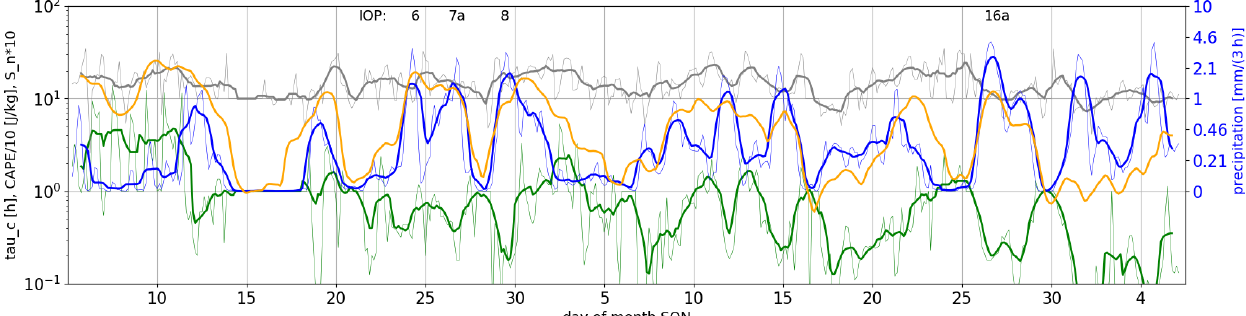
Figure 2. Time series of forecasted area-averaged ensemble mean precipitation (blue), convective adjustment timescale ( τ c , green), CAPE (orange) and normalized spread of precipitation ( S n , grey) in the northwestern Mediterranean coastal domain for the entire SOP1 period. Thick lines represent temporally smoothed data using a 24-hourly moving average, whereas thin lines indicate the raw 3-hourly data. Note that the y coordinate has a logarithmic scale, CAPE is divided by a factor of 10, S n is multiplied by a factor of 10 and precipitation is labelled on the right-hand side to increase readability.